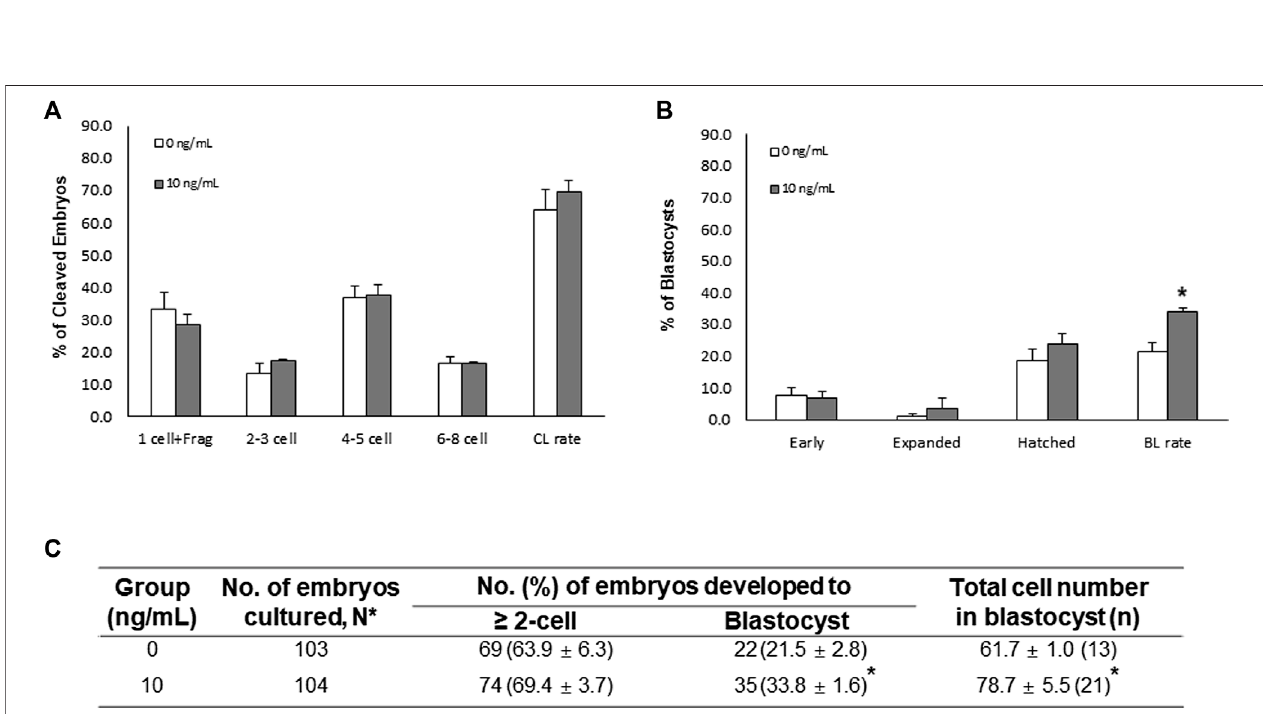
FIGURE 6 | Effects of neurotrophin-4 (NT-4) treatment during in vitro maturation (IVM) on embryonic development after somatic cell nuclear transfer (SCNT). (A) cleavage(CL)patternand (B) blastocyst(BL)formationpatternofSCNTembryos.* p < 0.05(Student ’ st-test).TheCLratewasmeasuredonday2,andtheBLformation rate was evaluated on day 7 of culture. Data are presented as the means ± SEM from three replicate experiments. (C) Summary of embryonic development after SCNT.